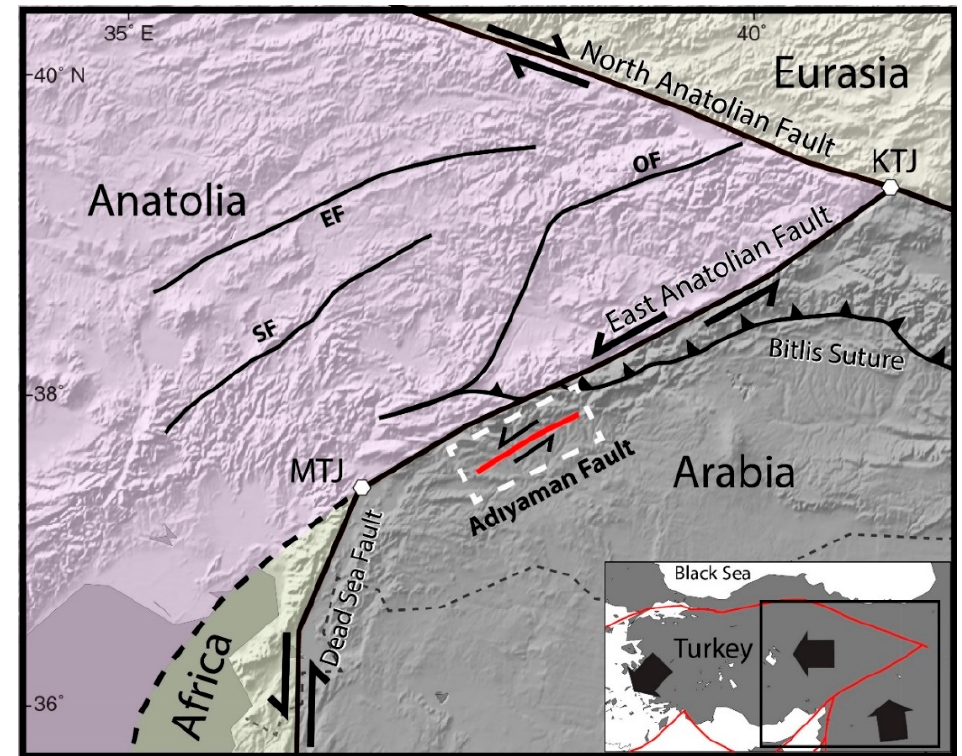
Figure 1. Shaded relief image (data from SRTM-30 [21]) of Eastern Turkey, showing the African, Arabian, Anatolian, and Eurasian lithospheric plates and major active faults (in thick black lines). The Ad ı yaman fault is shown by a thick red line. Abbreviations: MTJ, Mara ş triple junction; KTJ, Karl ı ova triple junction; EF, Ecemi ş fault; SF, Savrun fault; OF, Ovac ı k fault. Thick black arrows indicate the plates’ movement. The box with white dashed lines shows the location of the study area and Figure 2, respectively.